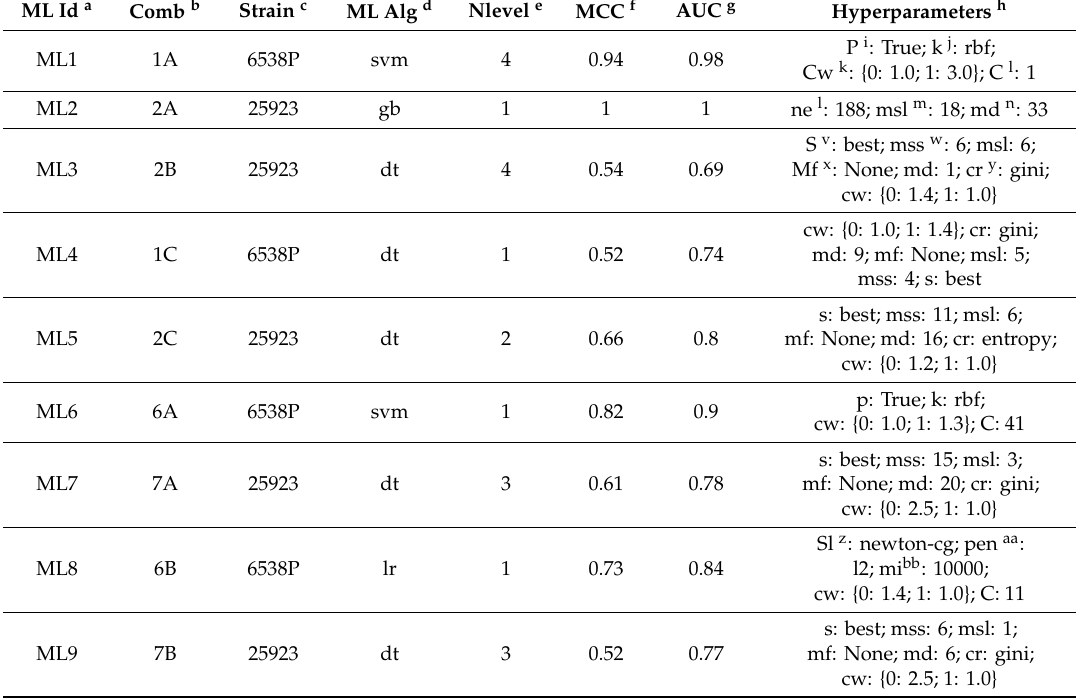
Table 2. List of machine learning (ML) models selected by MCC and ROC AUC values. Random search selected best hyperparameters are also